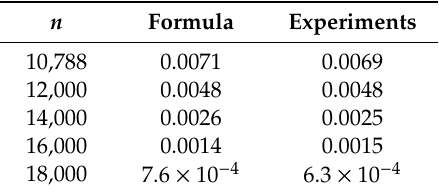
Figure 8. The probability of correct weight estimate: When the weight of the observed noise vector is optimal ( = 78), the experimental acceptance rate c while the OOV algorithm uses the approximation N this approximation leads to high error rate in the weight estimation process. Table 4. Probability that the OOV algorithm will correctly estimate the weight of the noise vector whose weight is optimal ( = 78). Both analytically and experimentally obtained results demonstrate the algorithm has exceptionally low accuracy.